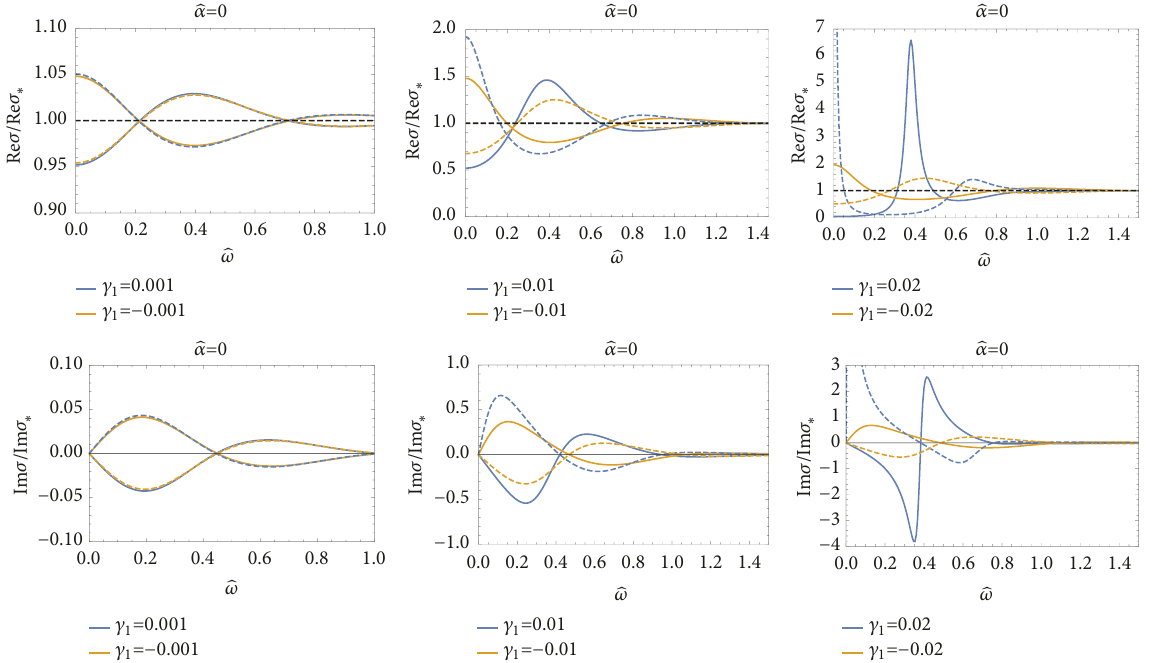
Figure 1: The real part (the plot above) and the imaginary part (the plot below) of the optical conductivity as the function of ̂𝜔 for ̂𝛼 = 0 and various values of 𝛾 1 . The solid curves are the conductivity 𝜎 of the original EM theory (4) and the dashed curves display the conductivity 𝜎 ∗ of the EM dual theory